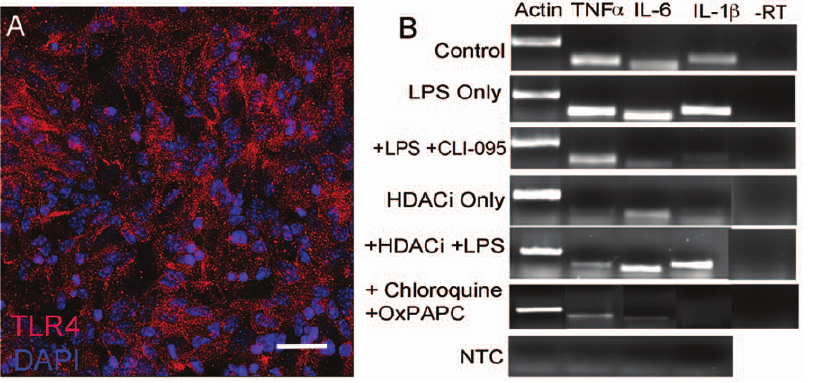
Figure 9. Components of Toll-like signaling in midbrain cultures. (A) TLR4 (red) expression in differentiated midbrain cultures. Nuclei are labeled with DAPI (blue). (B) The effects of HDACi (50 mM SB) and Toll-like signaling agonists and antagonists on the expression of down-stream products of Toll-like signaling (TNF a , IL-6, and IL-1 b ) in midbrain cultures. Control indicates midbrain cultures that were not treated with any drug. Treatment with the TLR4 agonist LPS increases the levels of all down-stream products of Toll-like signaling. The effects of LPS on Toll-like signaling can be blocked with the TLR4 antagonist CLI-095. HDACi treatment decreases the expression of TNF a and IL-1 b . Co-treatment of midbrain cultures with HDACi and LPS rescues the effects of HDACi on IL-1 b expression. Treatment with the Toll-like signaling antagonists Chloroquine and OxPAPC results in down regulation of TNF a , IL-6 and IL-1 b . No template control (NTC) was performed to rule out contamination of the PCR reactions. All RNA samples were used in a cDNA amplification reaction that did not contain reverse transcriptase (-RT), to rule out contamination with genomic DNA. –RT controls were amplified by PCR using b -actin primers. Gel is representative of at least 2 separate experiments. Scale bar=50 m M.